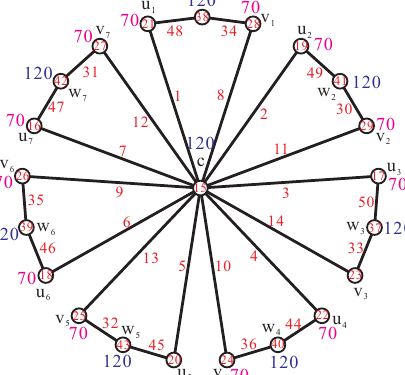
Figure 8. The local antimagic total labeling of D 7 The exact value of each edge and vertex of the local antimagic total labelings for n ≤ 6 are given in Tables 1–5.